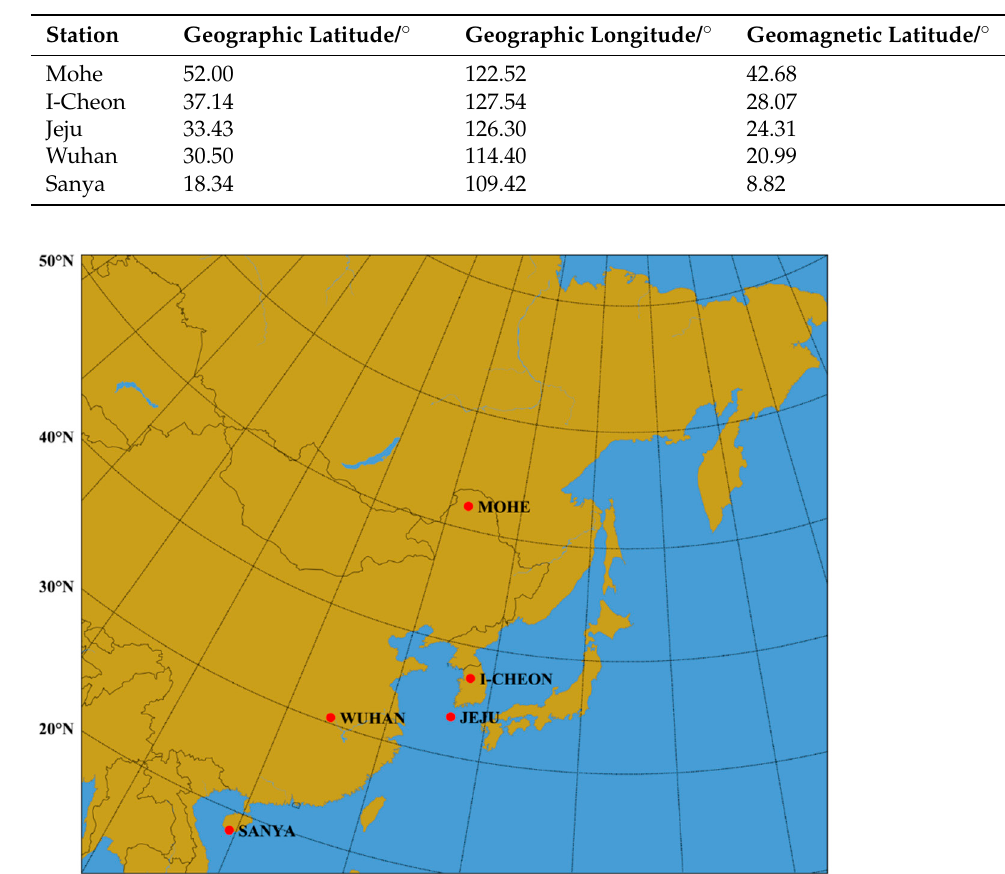
Table 1. The geographical coordinates of the selected stations.